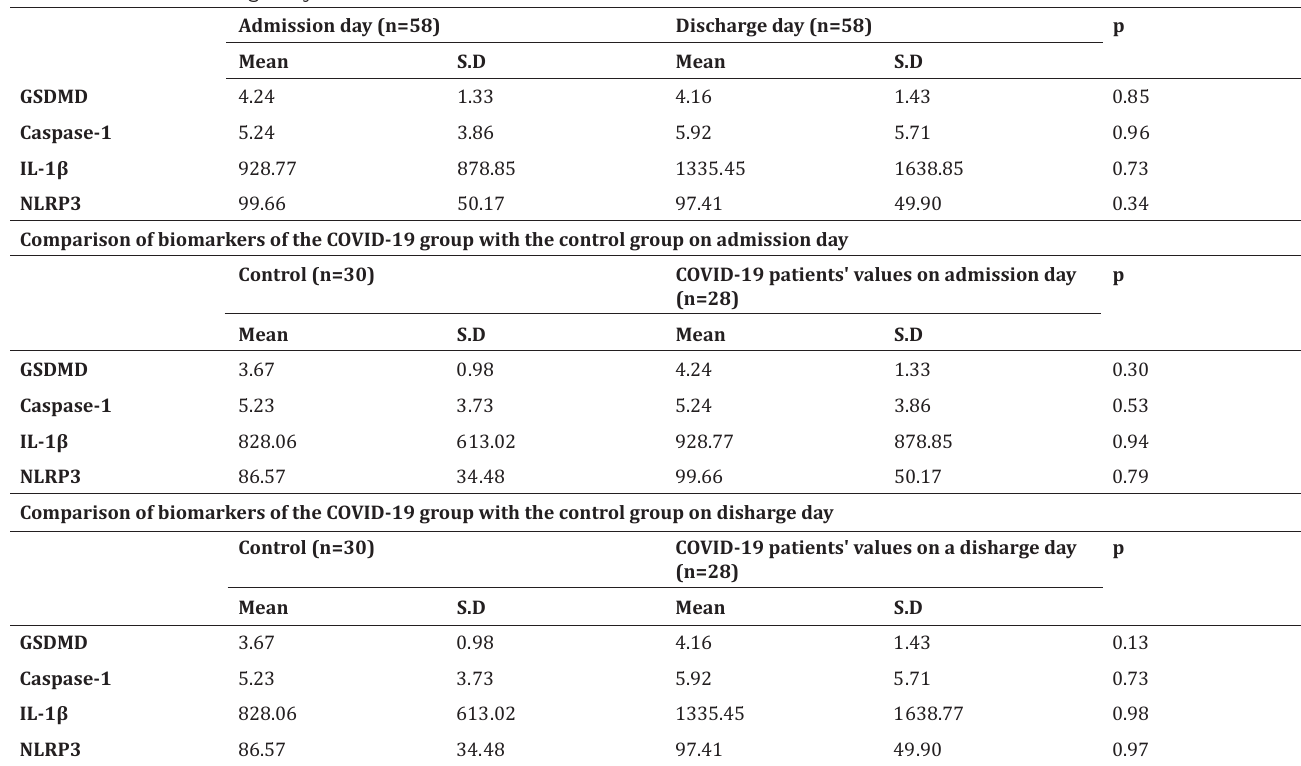
Comparison of GSDMD, Caspase-1, IL-1 β and NLRP3 values of case and control groups on hospitalization day and discharge